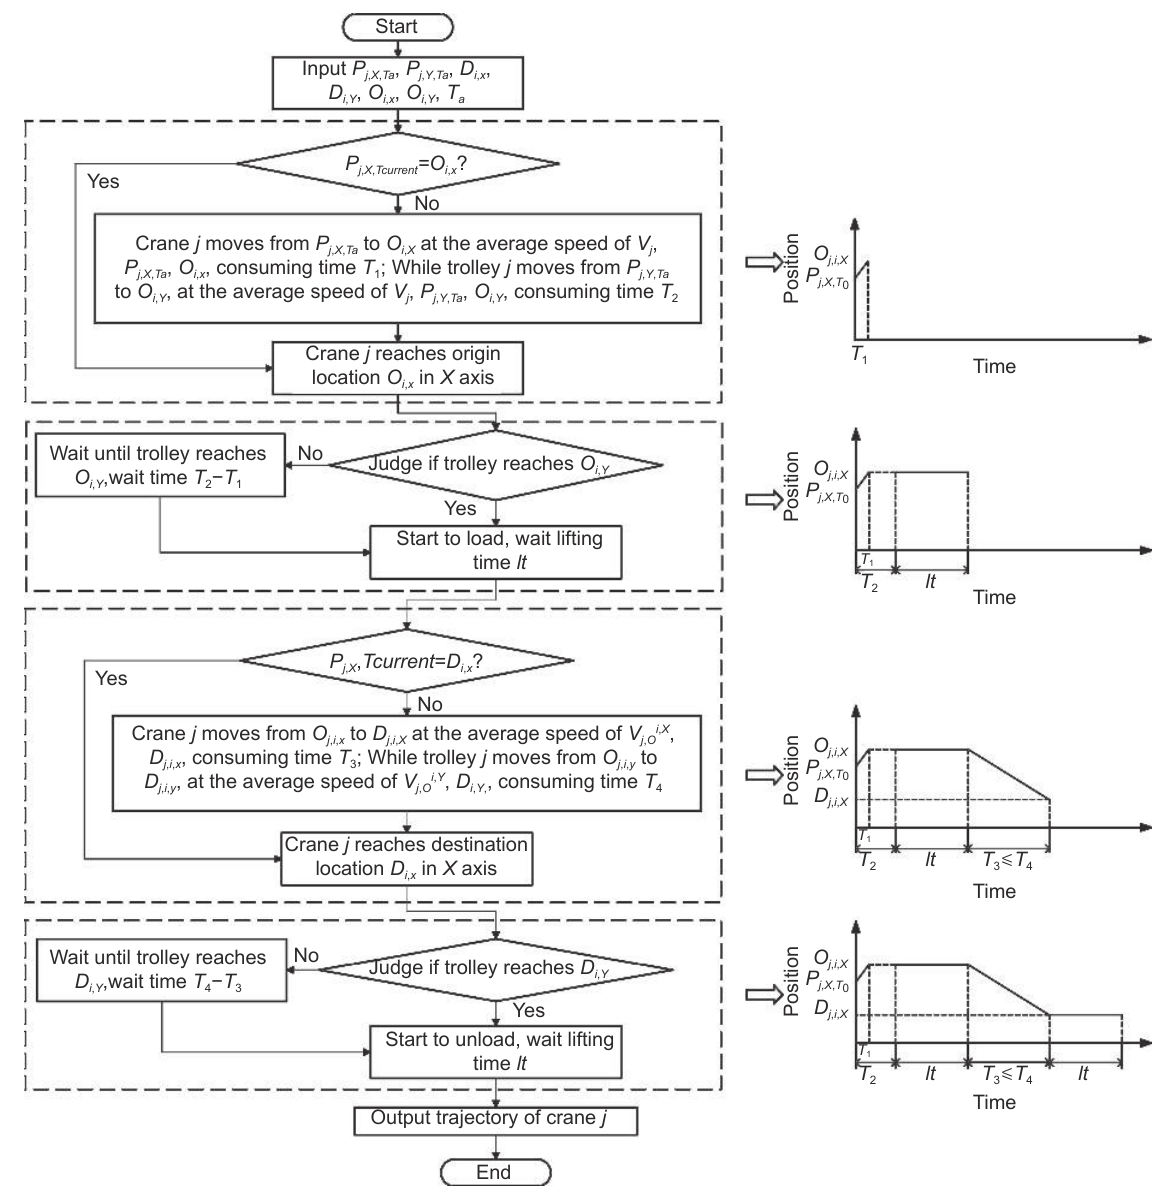
Fig. 4 Procedure of a single-crane trajectory